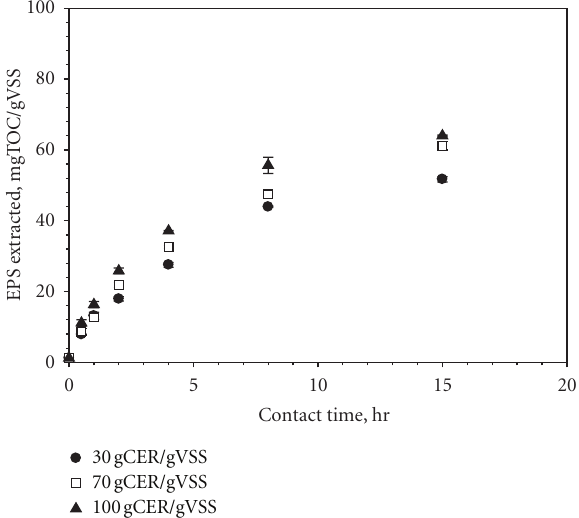
Figure 1: E ff ect of contact time and CER dose on EPS extraction yield (stirring intensity = 600 RPM).